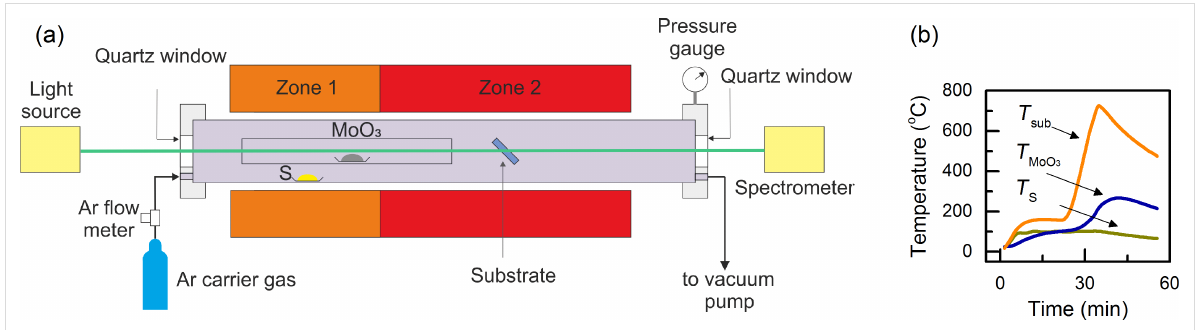
strates using CVD. The monolayers on both sides of the sub- strate were homogeneously distributed over the 10 × 10 mm substrate surfaces. Most importantly, the evolution of the optical transmittance of the substrate has been monitored in situ in real time during the CVD growth using DTS. The formation of the MoS 2 monolayers is clearly visible from the develop- ment of the DT spectrum. More specifically, the onset of the growth and the variation of the growth rate of MoS 2 mono- layers can be determined. This detailed information about the growth deduced from the DTS results can be correlated very well to the variation of the temperature of the substrate, the MoO 3 , and the sulfur sources. The current results emphasize the importance of the in situ real time study and pave the way for deeper understanding, and eventually, the precise controlled growth of 2D semiconducting